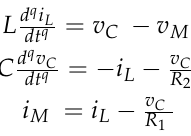
Figure 7. Fractional-order memcapacitive chaotic circuit.